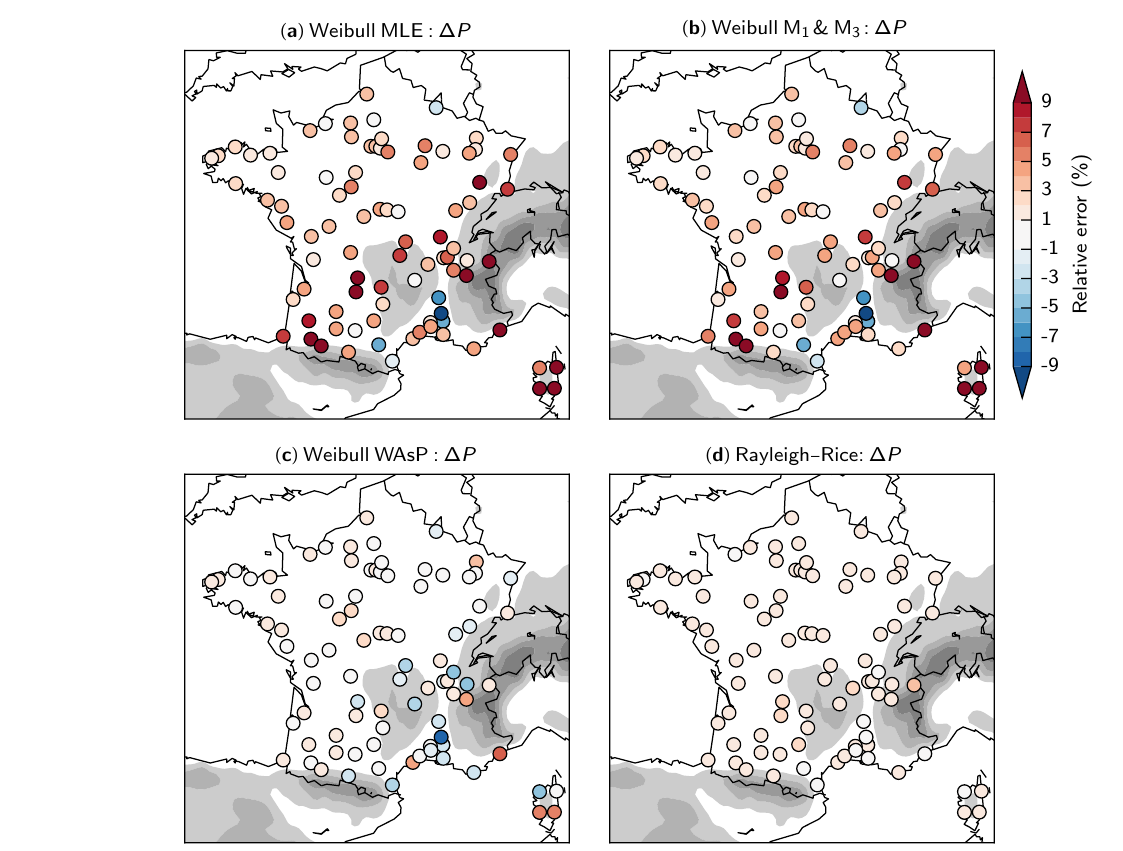
Figure 3. Maps of (cid:49)P , i.e., the relative errors in wind power production due to the statistical modeling, at the 89 stations for either the Weibull distribution fit by the maximum likelihood method (a) , the first and third moments method (b) , and the WAsP method (c) , or the Rayleigh–Rice distribution (d)